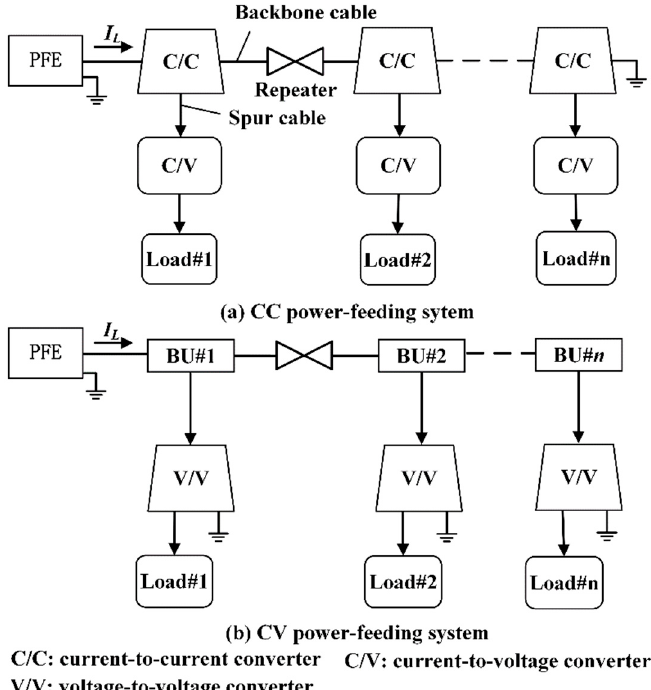
Figure 2. Two types of power systems in cabled seafloor observatories (CSOs). ( a ) Constant-current power-feeding system. ( b ) Constant-voltage power-feeding system.